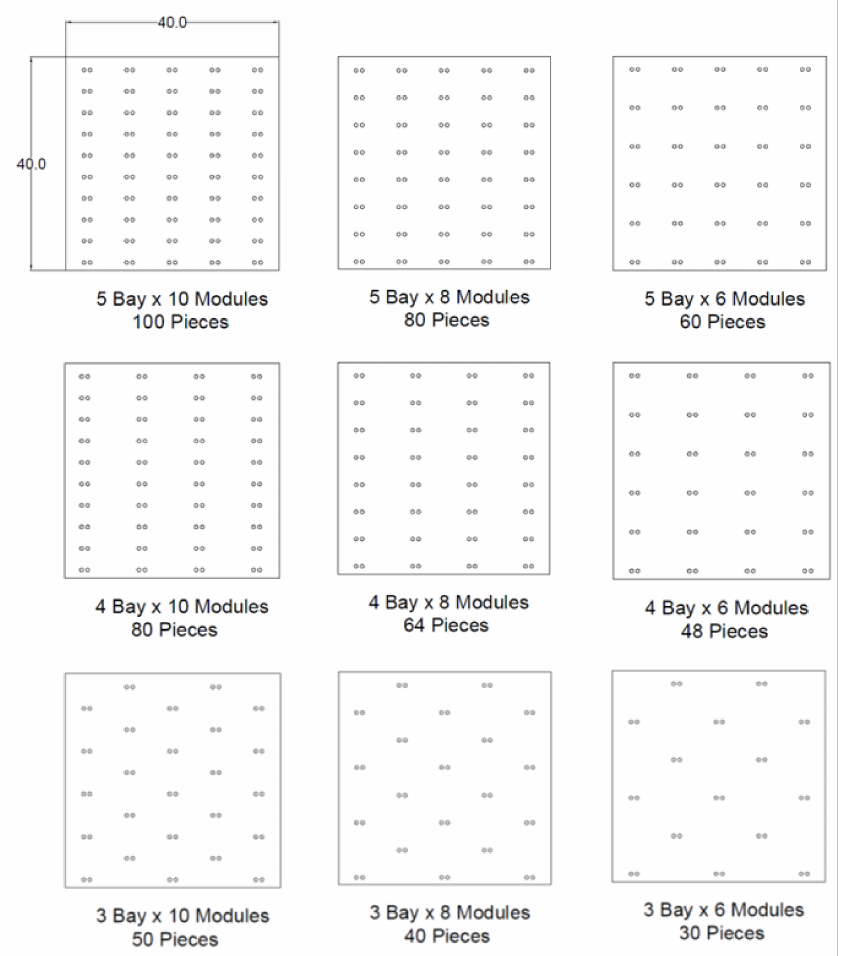
Figure 8. Top view of CSP Topography Configuration options for shear